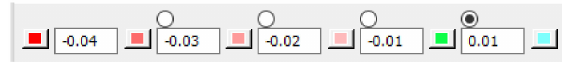
Figure 3. Color scale with deviation values for the CAM